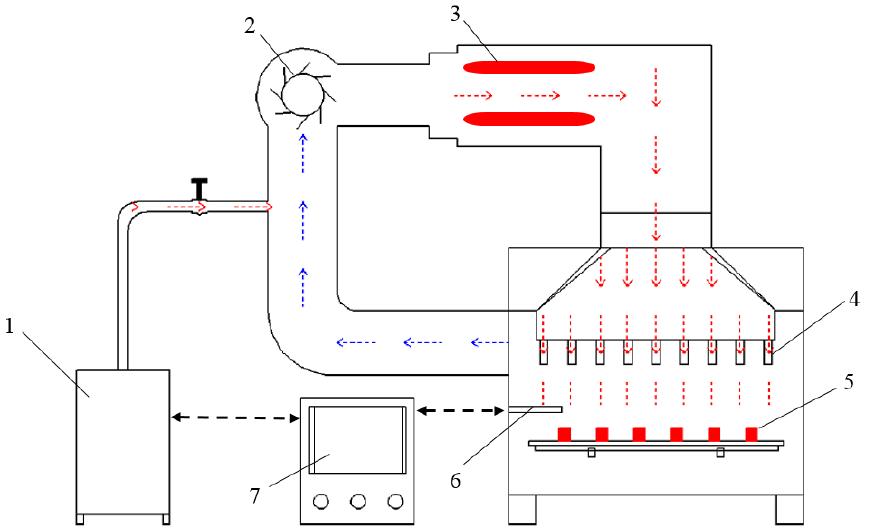
Figure 2. Schematic diagram of HHAIB equipment. (1) Steam generator; (2) centrifugal fan; (3) electric heating assist; (4) impingement round nozzle; (5) material tray; (6) temperature and humidity sensor; (7) control system.